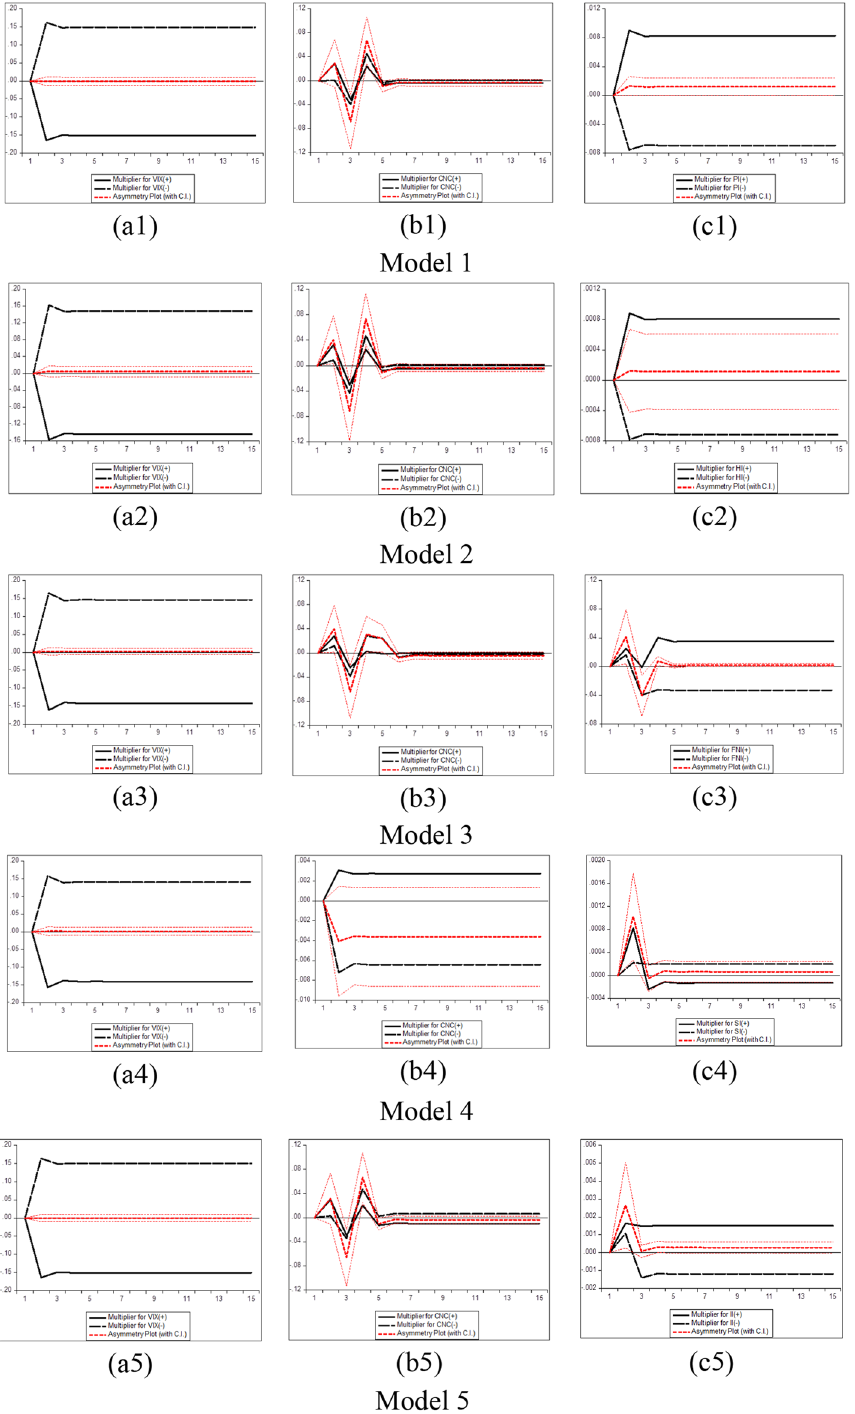
Fig. 4 Asymmetric dynamic multipliers—Models 1–6: impact of positive and negative changes in VIX (a1– a6), daily number of new reported COVID-19 cases worldwide (b1–b6), each RavenPack coronavirus related indices (c1–c6) on daily changes of Bitcoin price. Source Authors’ own work. Notes: The horizontal axis shows the period (days) and the vertical axis the multiplier for positive (continuous black line) and negative (dashed black line) changes in VIX, daily number of new reported COVID-19 cases worldwide, each RavenPack coronavirus related indices and the asymmetry plot (dashed red line) with 95% bootstrap confidence interval based on 1000 replications. Variables’ description is provided in Table